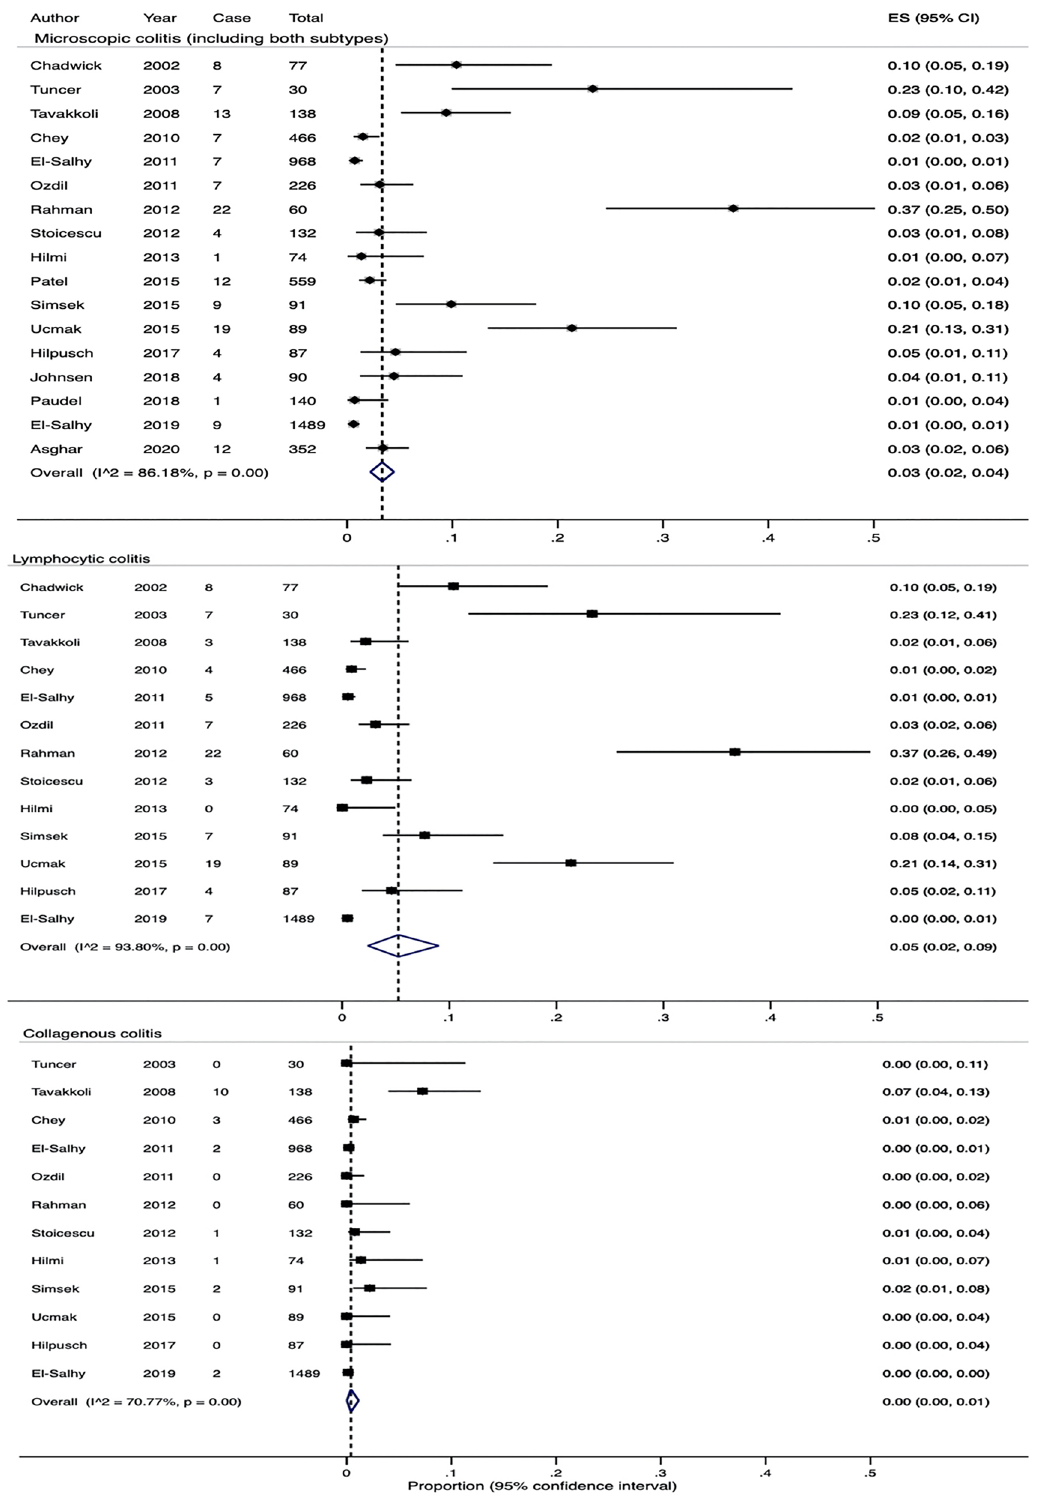
Figure 4. Forest plots showing the estimated pooled prevalence of MC and both subtypes—lymphocytic colitis and collagenous